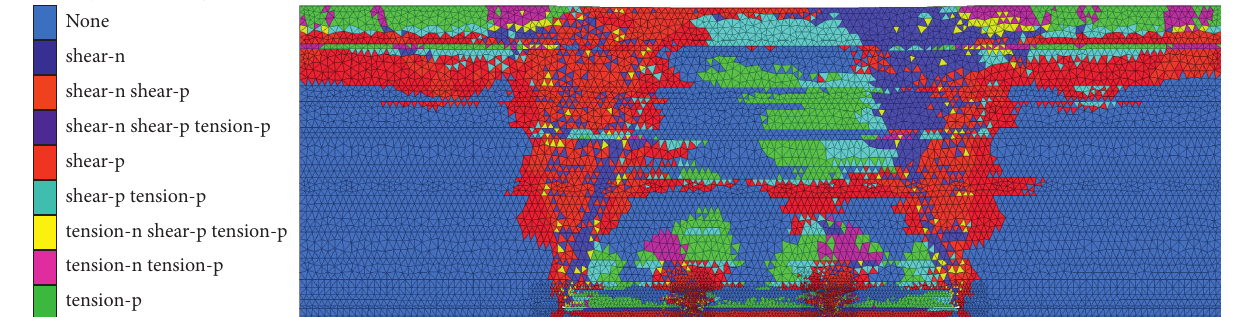
Figure 24: Yield state of rock